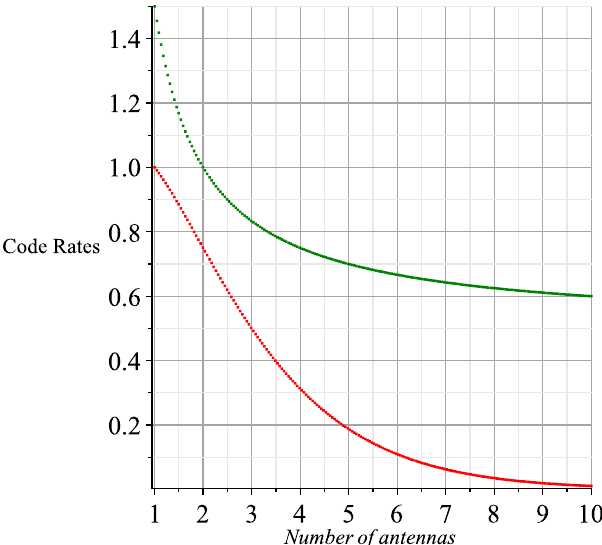
Figure 2. The code rate R Q of QODs based on new approach remains stable around 0.5.